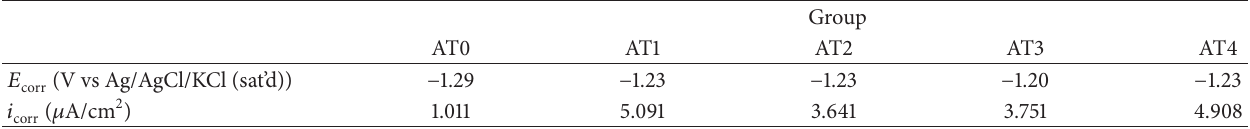
Table 4: Electrochemical corrosion parameters of Mg-35Zn-3Ca alloy in HBSS, derived from the potentiodynamic polarization test using Tafel extrapolation method.